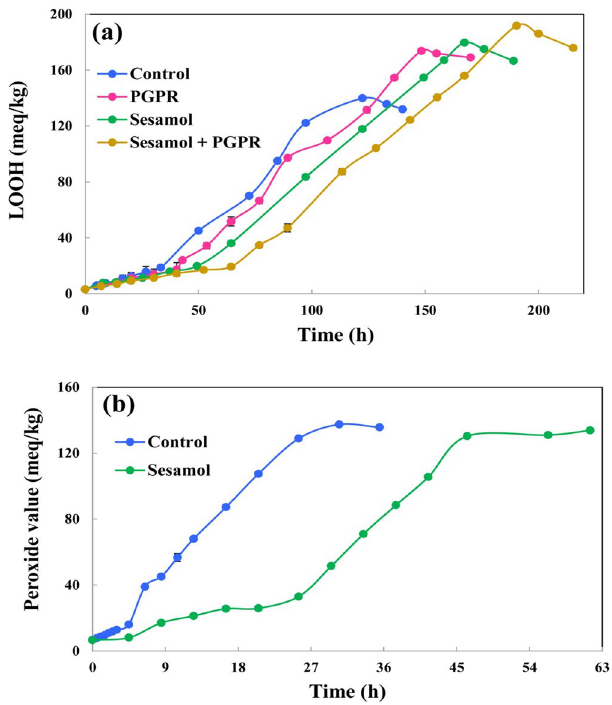
Figure 2. Sigmoidal curve of lipid hydroperoxides (LOOH) accumulation in peroxidation of ( a ) sunflower oil and ( b ) sunflower oil-in-water emulsion samples at 55 °C. PGPR polyglycerol